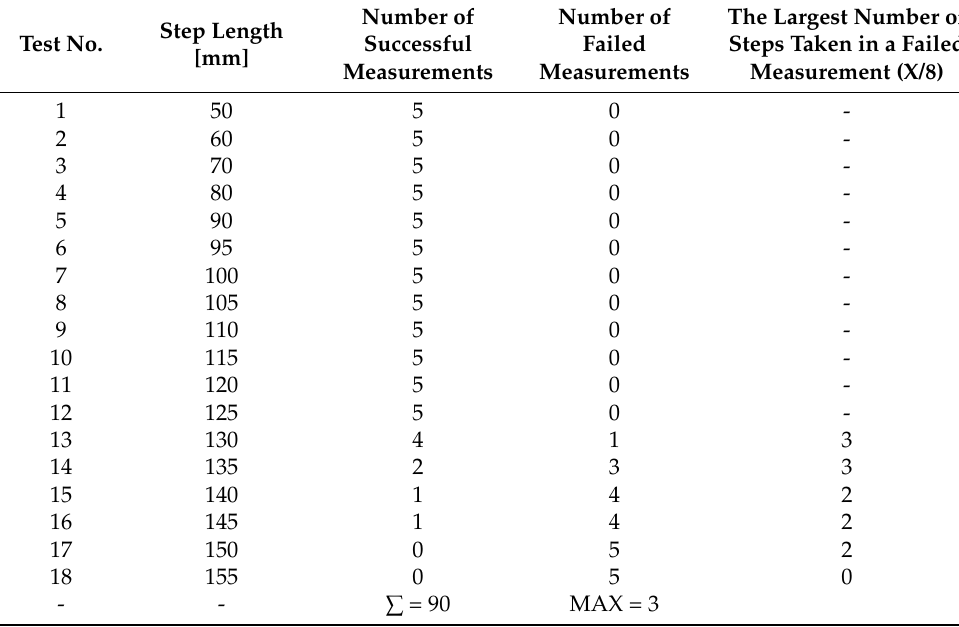
Table 7. Functionality testing results of a bipedal robot.